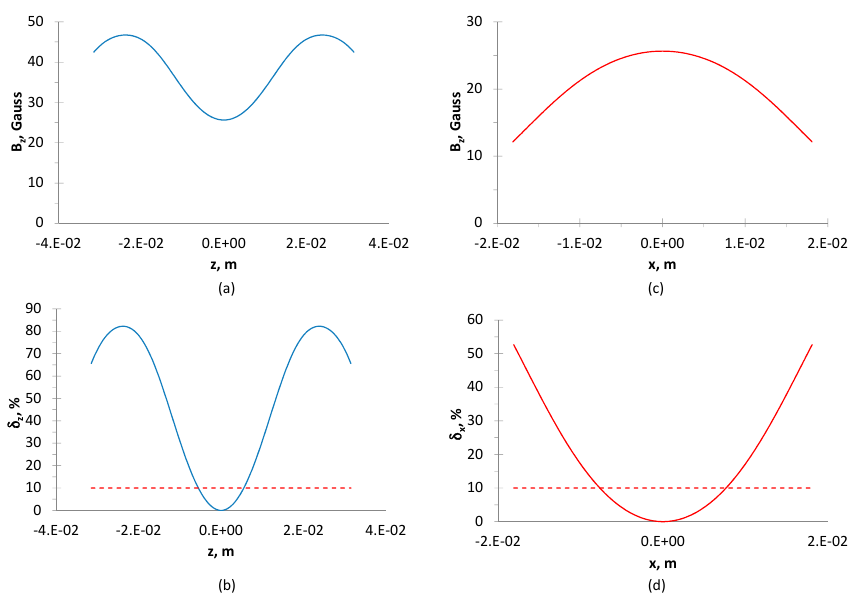
Figure 4. ( a ) Axial distribution of the magnetic field B z . ( b ) Relative uniformity δ z along z axis. ( c ) Radial distributions of the magnetic field B z . ( d ) Relative uniformity δ x along x axis. Calculated in the geometry of Figure 1c with 4 loops centered at z Q = − 31.5, − 18.1, 18.1, 31.5 mm, the loop radius is R = 18.1 mm, the current in each loop is I = 77.4 A.